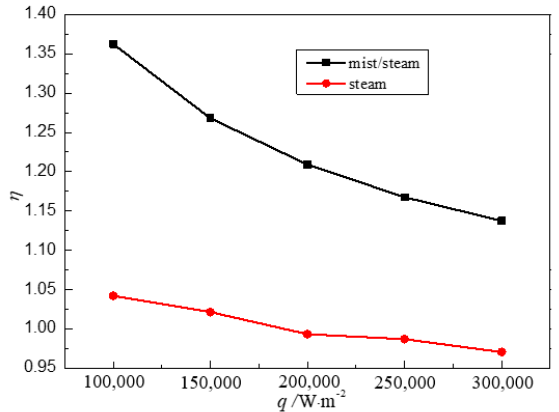
Figure 17. Variation in the heat transfer performance factor of the mist / steam and steam cooling channels with the wall heat flux density.